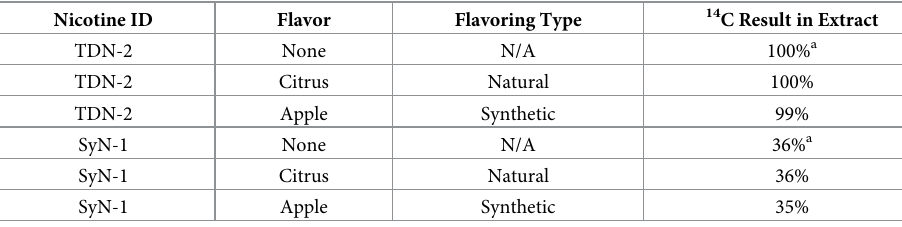
Table 2. Radiocarbon analysis of lab-prepared e-liquid formulation